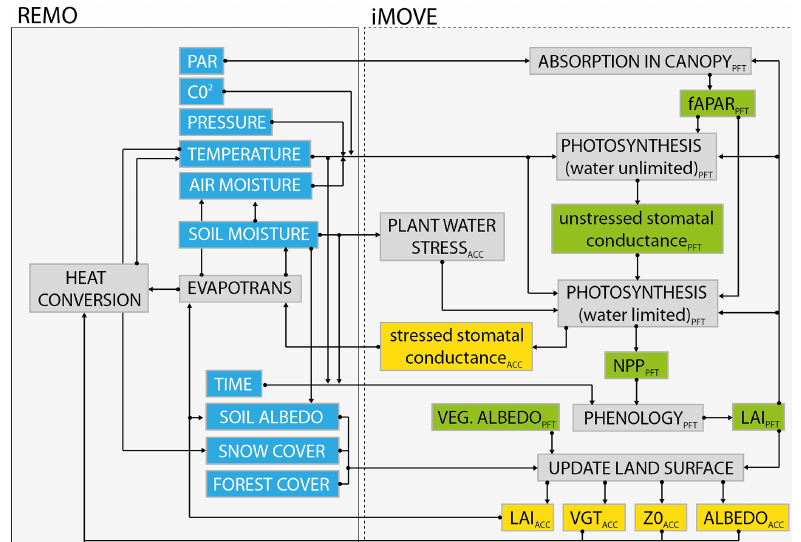
Figure 1. Coupling concept of